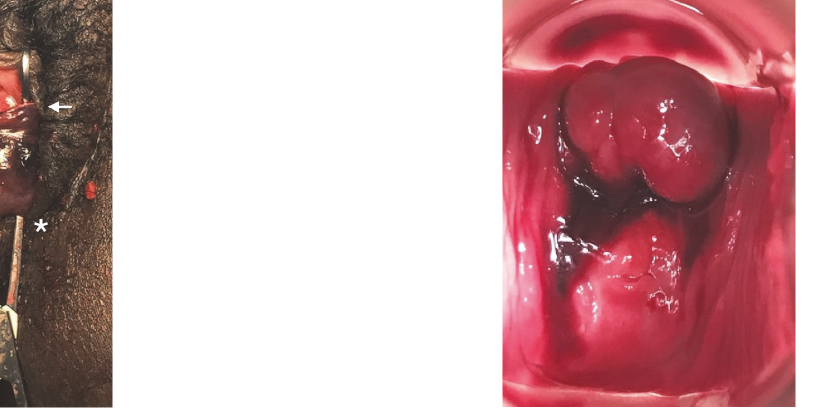
Figure 1: Intraoperative identification of cervical detachment of the necroticanteriorrimofthecervixinacompleteannulardetachment in a multiparous woman in the setting of a failed trial of labor after cesarean delivery. Asterisk indicates external os. Arrow indicates rim of anterior annular avulsion. Cervical canal canalized by ring forceps.